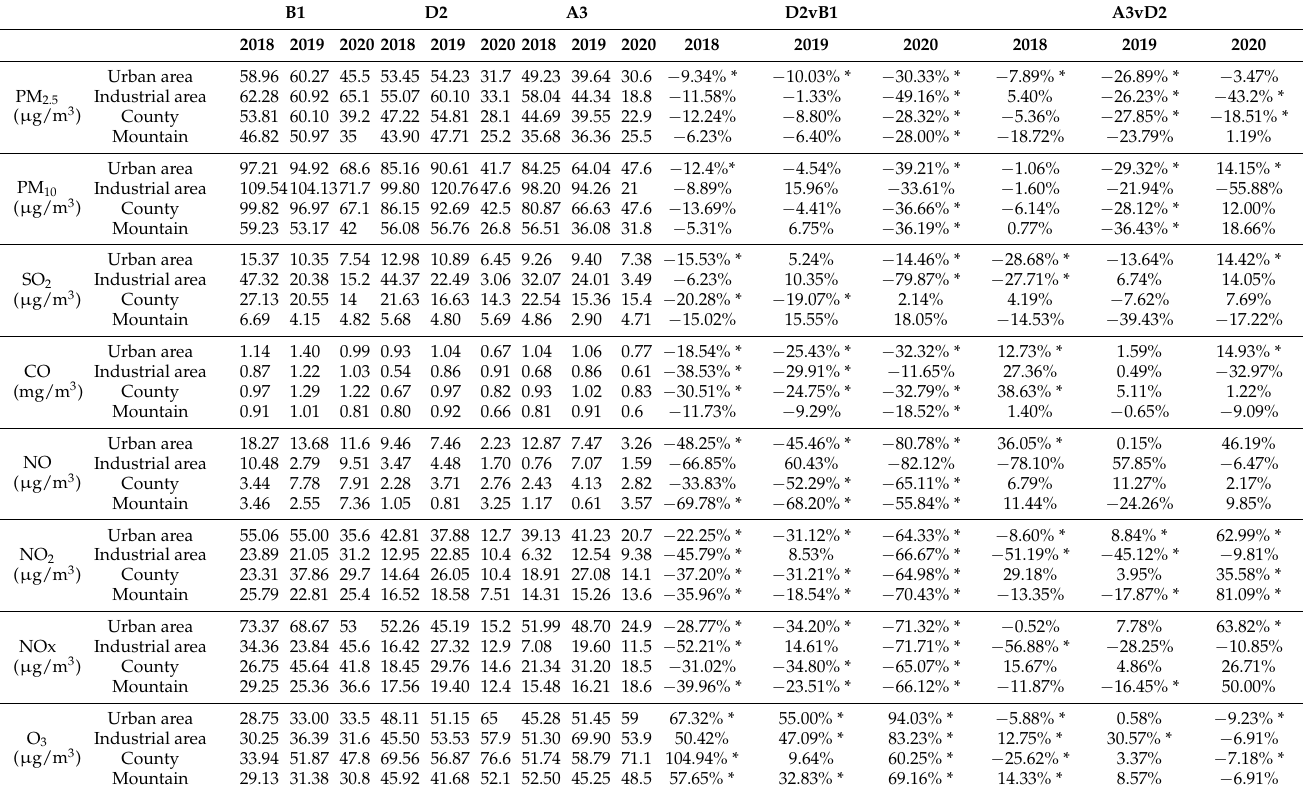
Table 1. Mean concentration of PM 2.5 , PM 10 , SO 2 , CO, NO, NO 2 , NOx, and O 3 during the three periods and the relative changes between the three periods in 2018, 2019, and 2020.